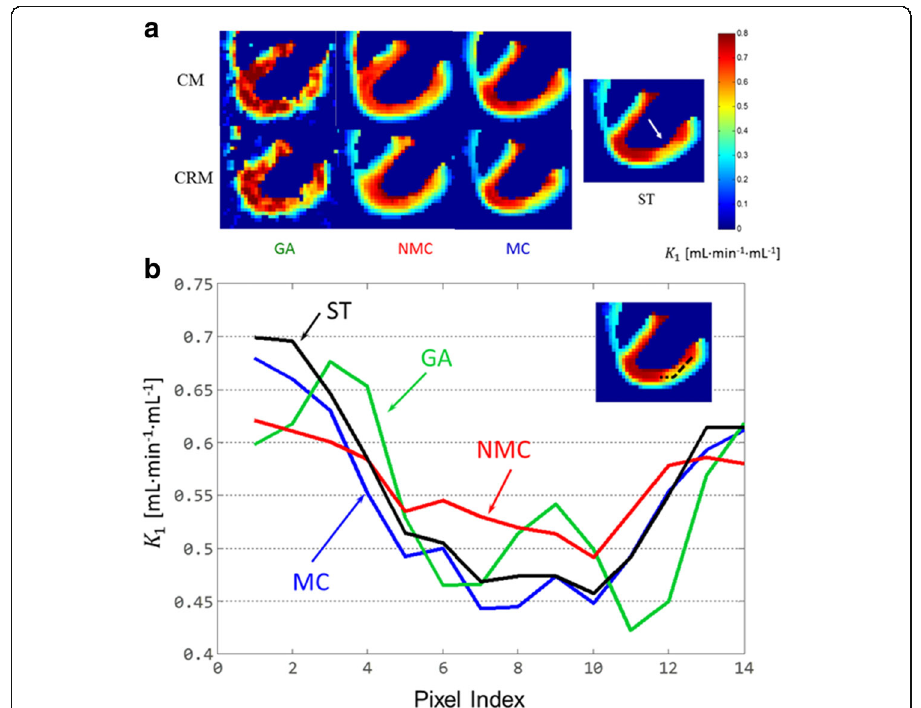
Fig. 6 Estimated K 1 maps and line profiles. a GA, NMC, and MC K 1 maps for CM and CRM as well as ST K 1 map. The GA, NMC, and MC K 1 maps are for one noise realization. The arrow on the ST map points to the defect. b GA, NMC, MC line profiles (for CRM) as well as ST line profile. The profiles were drawn along a line (shown on the map at the top-right corner) connecting the anterobasal and apical regions and going through the center of the defect